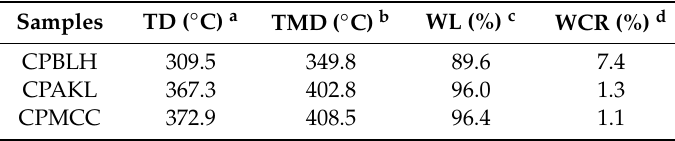
Figure 5. ( a ) TGA and ( b ) DTG curves of CPBLH, CPAKL, and CPMCC samples. Table 2. Thermal analysis data of CPBLH, CPAKL, and CPMCC. Samples